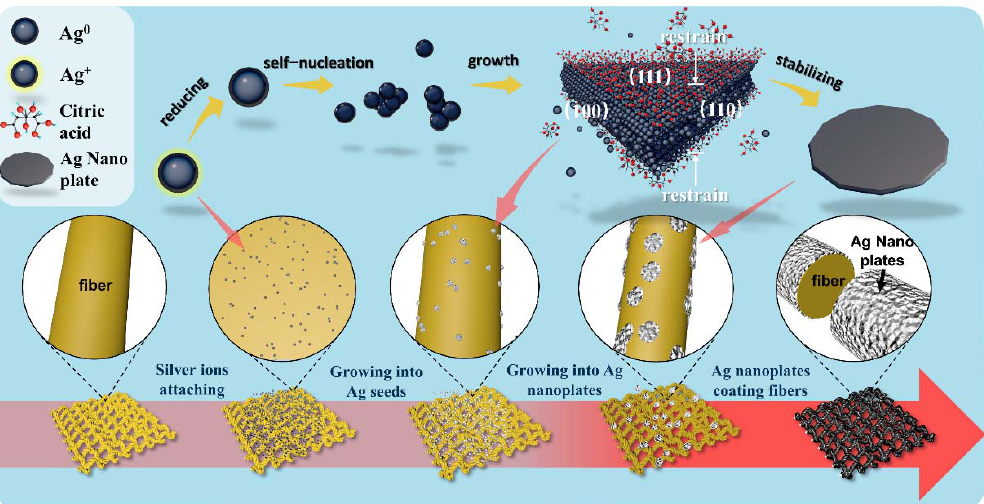
Figure 1. Growth mechanism of Ag nanoplates and growth process of Ag nanoplates on fabric.